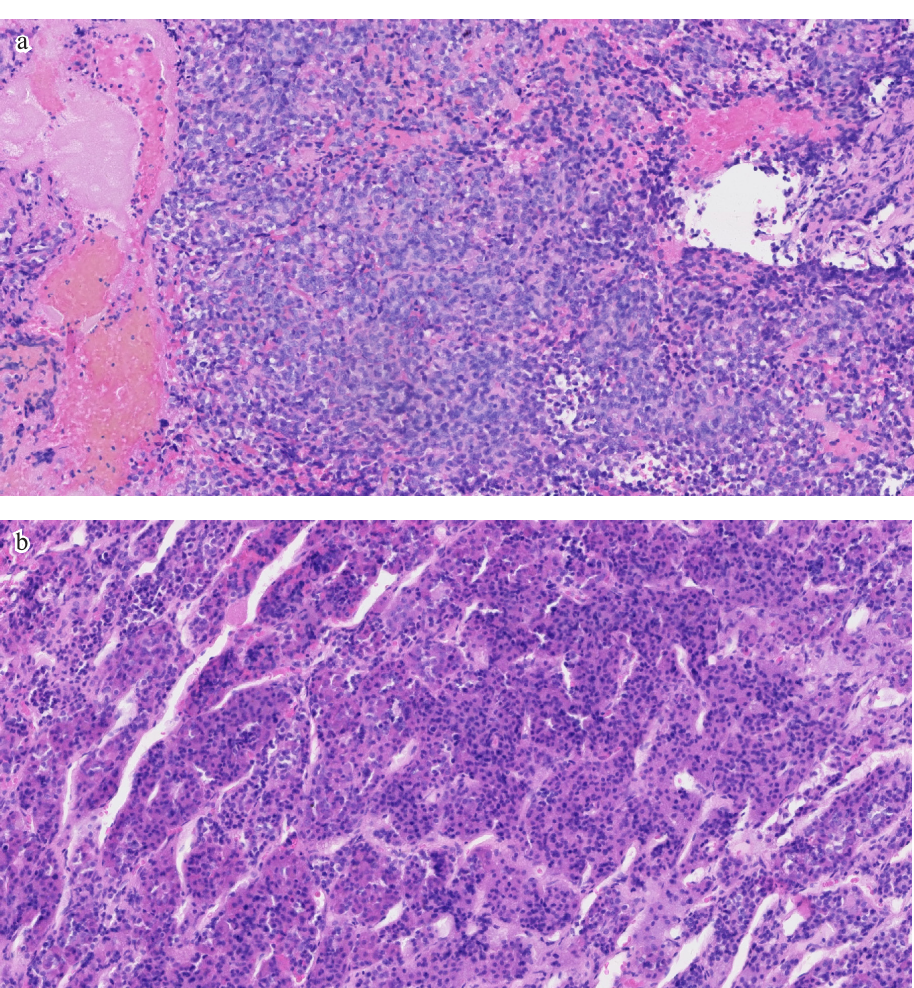
Fig. 4a, 4b. Histopathology of the adenoma of the pituitary gland. A tumour consisting of trabecu- lae of polygonal cells with uniform, round to oval nuclei with smooth chromatin and amphophilic cytoplasm. No mitoses or necrosis present. Haematoxylin-eosin staining